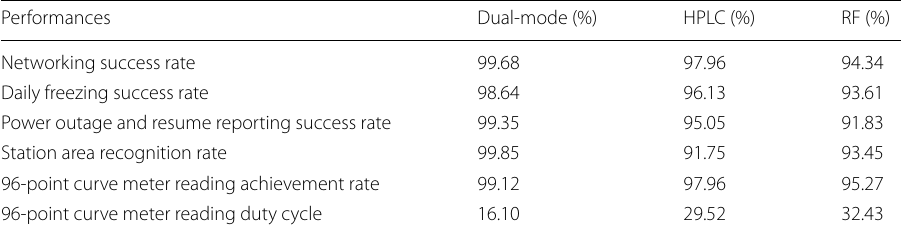
Table 3 Test data of three kinds of communication mode field network in laboratory Performances Dual-mode (%) HPLC (%) RF